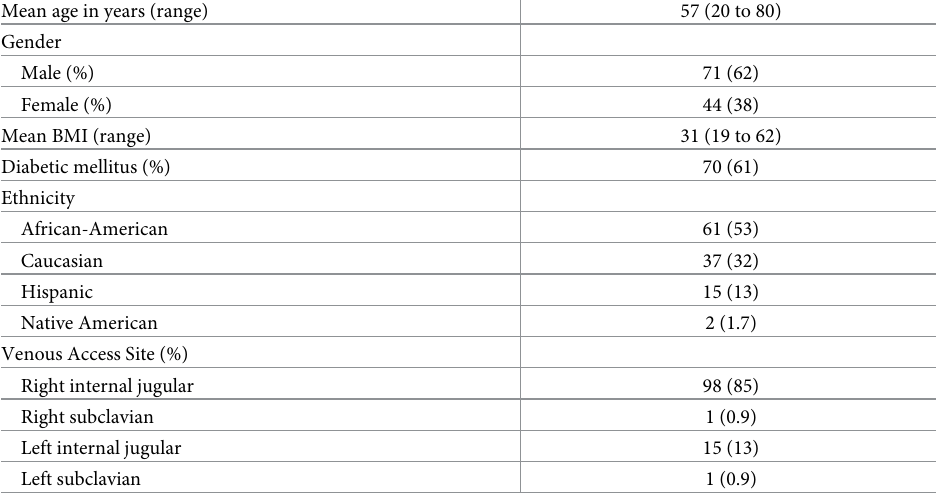
Table 1. Patient